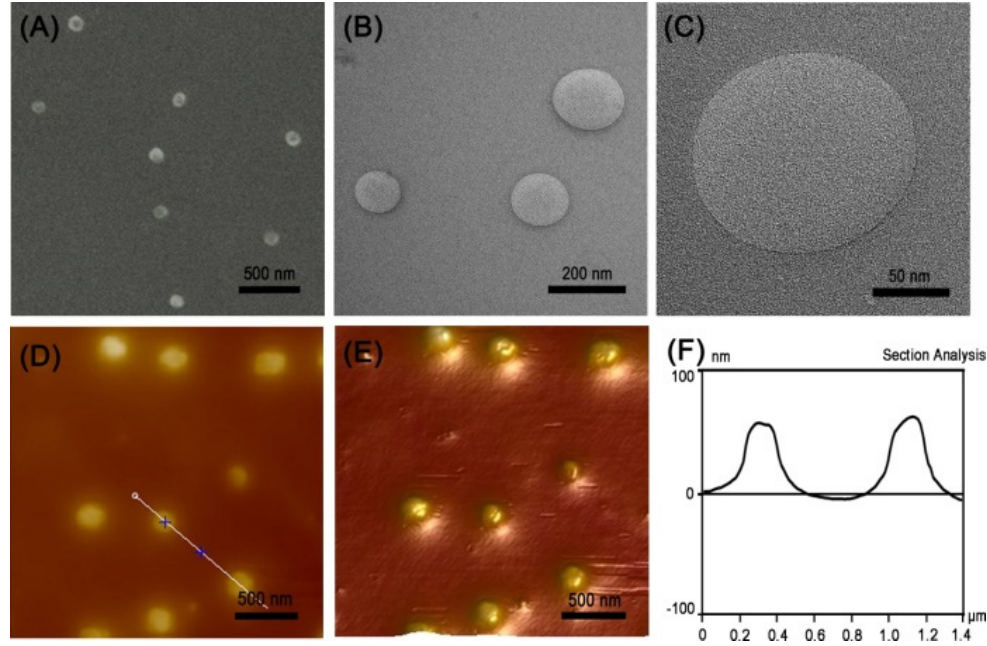
Figure 2. ( A ) SEM image, ( B , C ) TEM images, ( D ) AFM image, ( E ) 3D AFM image of the nanocapsules, and ( F ) associated height curve along the black line in panel D.